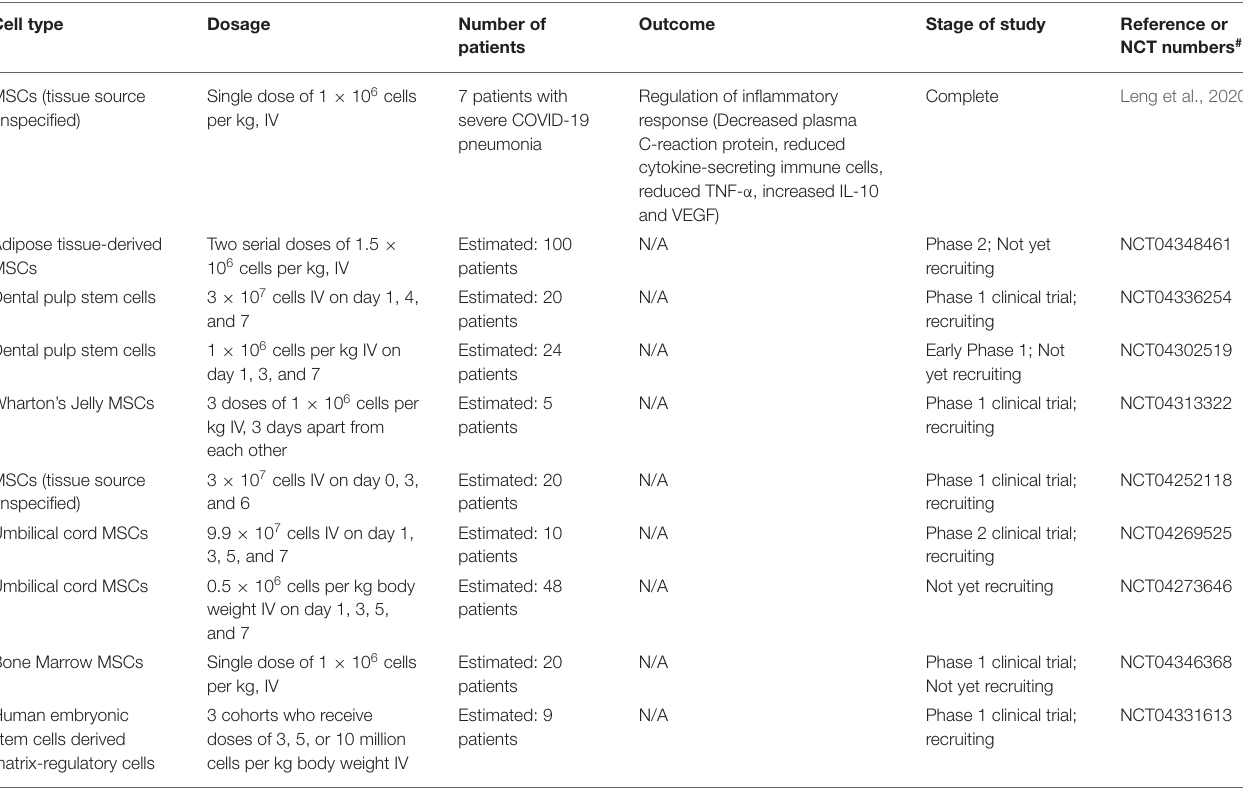
TABLE 1 | Selected clinical studies using stem cells for the treatment of SARS-CoV-2 infection.